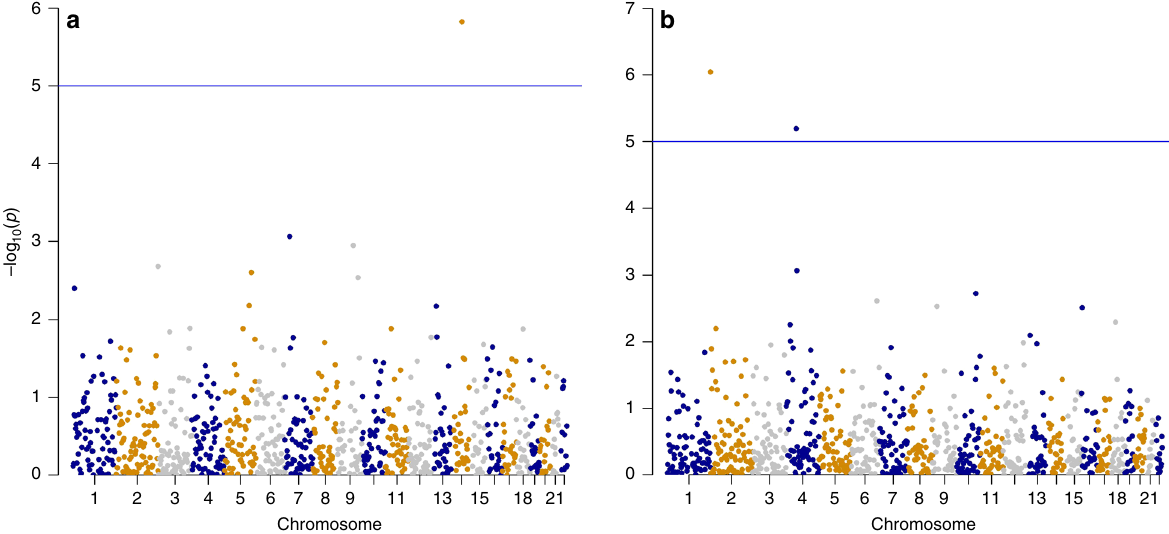
Fig. 4 Inbreeding depression in genomic windows. ID was measured in 1000 three Mb-wide non-overlapping sliding windows along the genome; the p -value threshold was corrected by Bonferroni and set at < 1 × 10 − 05 . a Inbreeding depression on body mass index (BMI) for men. A window on chromosome 14 (position 63-66 Mb) was highly signi fi cant. 23 protein coding genes were found in this window as shown in Table S5. Two SNPs located in this window, in KCNH5 and FUT8 , were associated with BMI in GWAS studies. b Inbreeding depression on visceral adipose tissue (VAT) for women. Two windows on chromosomes 2 (position 0-3 Mb) and 4 (position 57-60 Mb) were signi fi cant. 9 protein coding genes were found in the chromosome